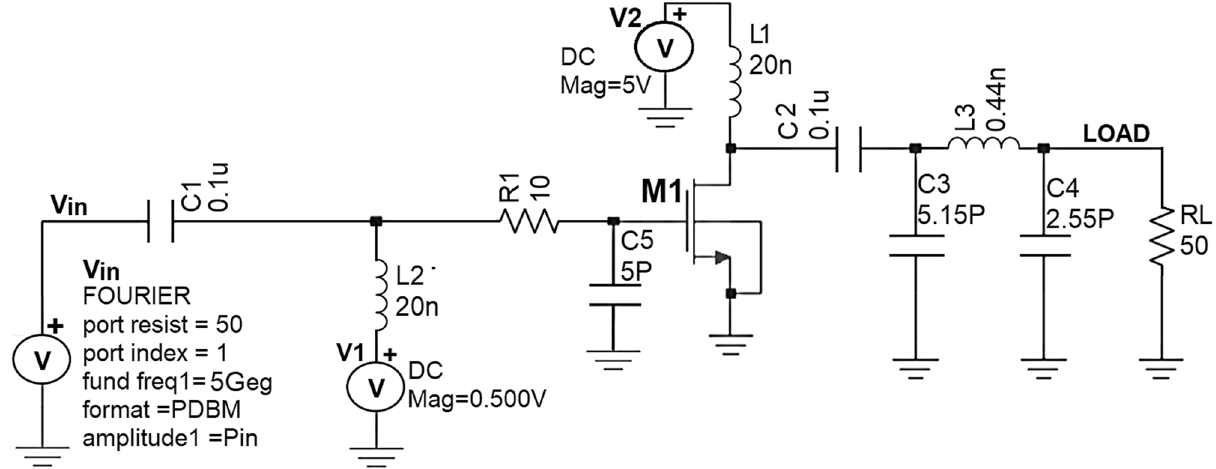
Figure 14. Schematic circuit of the proposed Class-J PA with Fourier input source at 5 GHz.